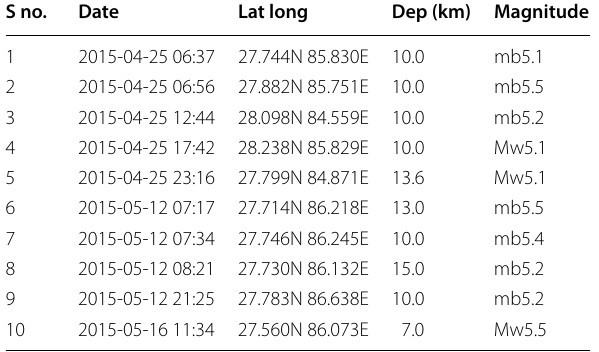
Table 1 Moderate earthquakes considered for the HVSR method for fixed stations. The magnitudes of the earth- quakes range from M5 to M5.5